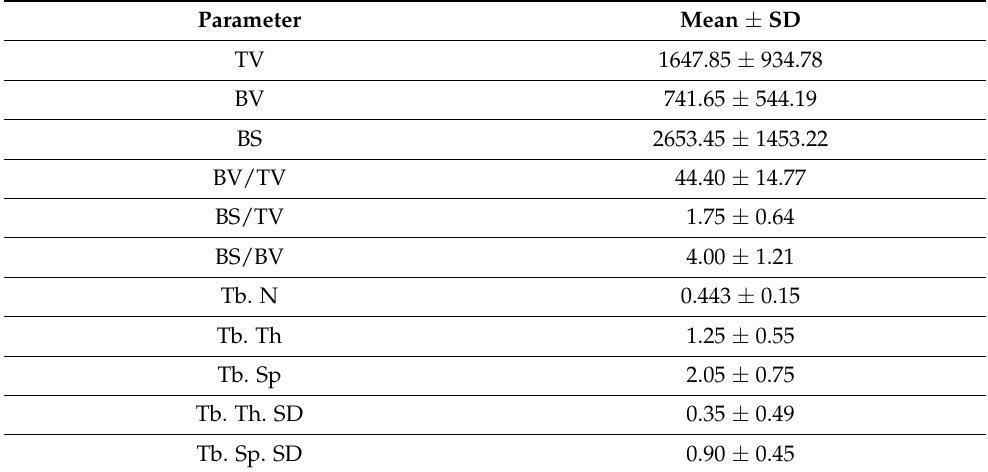
Table 3. The mean and standard deviation (SD) of the TBM parameters.